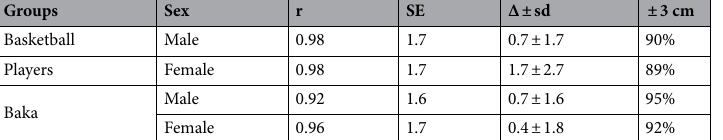
Table 4. Correlation and standard error between actual and estimated adult stature. Average values ( Δ ) and standard deviation between actual and estimated adult stature and proportion of individuals for whom the difference between actual and estimated adult stature is less than 3 cm.